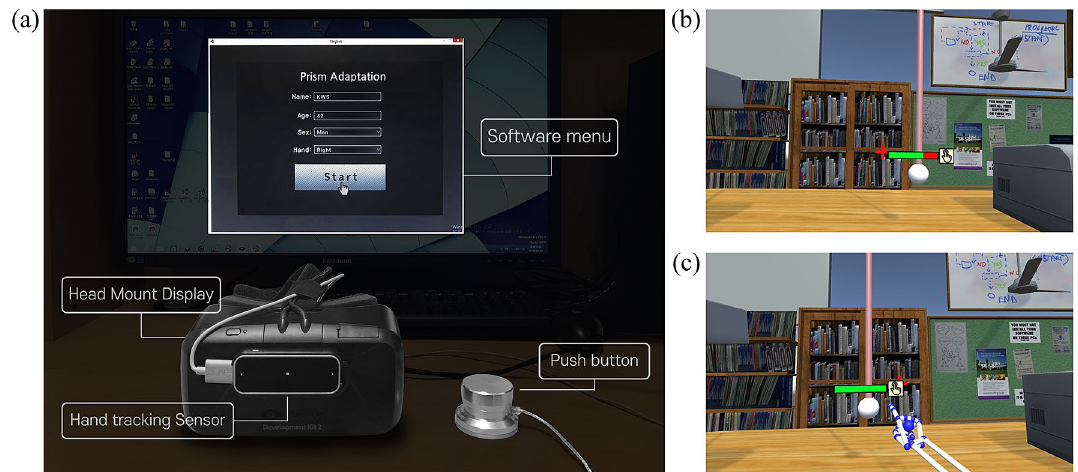
Figure 2. VPAT system configuration. The Oculus rift DK2 was used as a head mount display for VR rendering. Leap motion was used for hand tracking. ( a ) A push button was used during clicking sessions in our experiment, and the software menu was constructed to save user’s information including name, age, gender, and the hand side used for training. ( b ) Environmental design for the experiment. The red cross marked on the bookshelf is used to calibrate the body and center of vision. A white ball is used as the target for pointing. The remaining trial time is indicated by a health bar, and to the right is an icon showing the current task. ( c ) Visual feedback is only given when the index finger is reached into visible area.